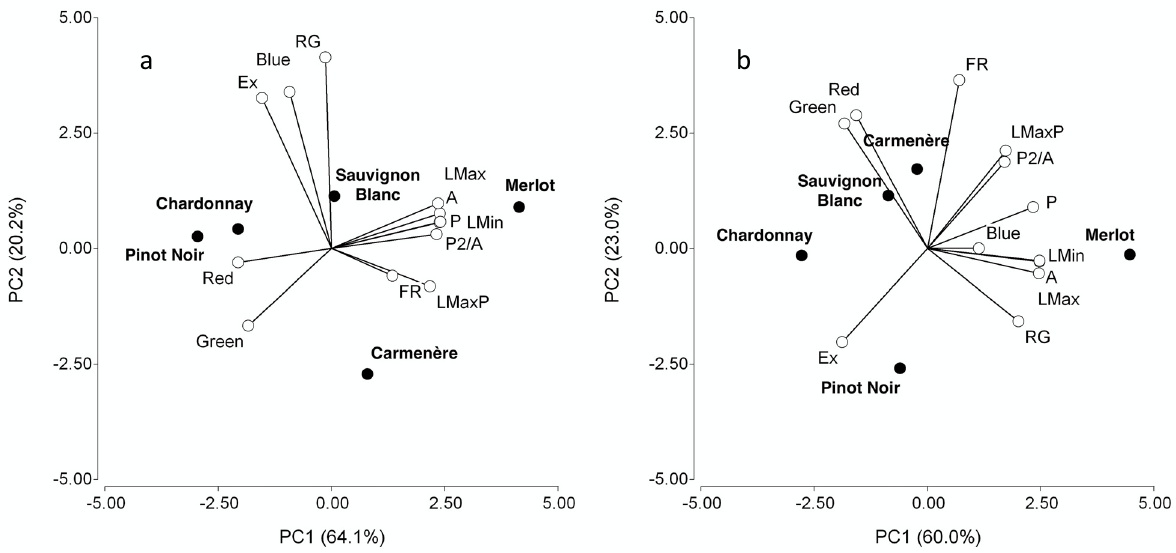
Figure 3. Principal component analysis (PCA) graph combining score plot and loadings for leaf morpho-colorimetric parameters obtained from five different grapevine varieties managed under stress water conditions (left, a ) and no water restriction (right, b ).